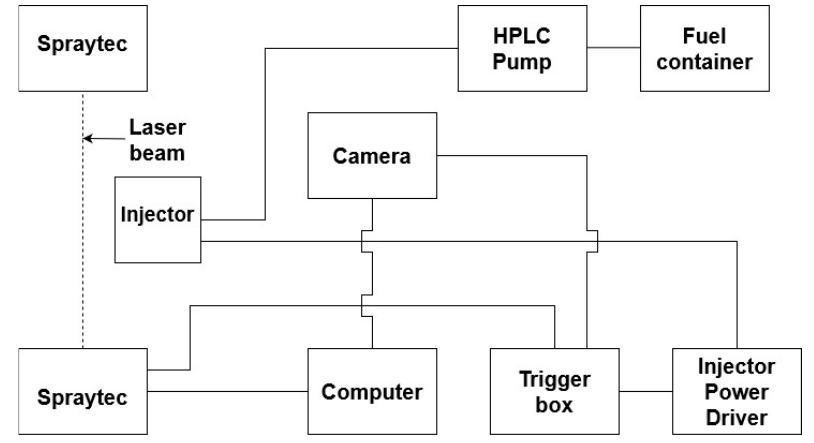
Figure 3. Test bench for spray analysis.